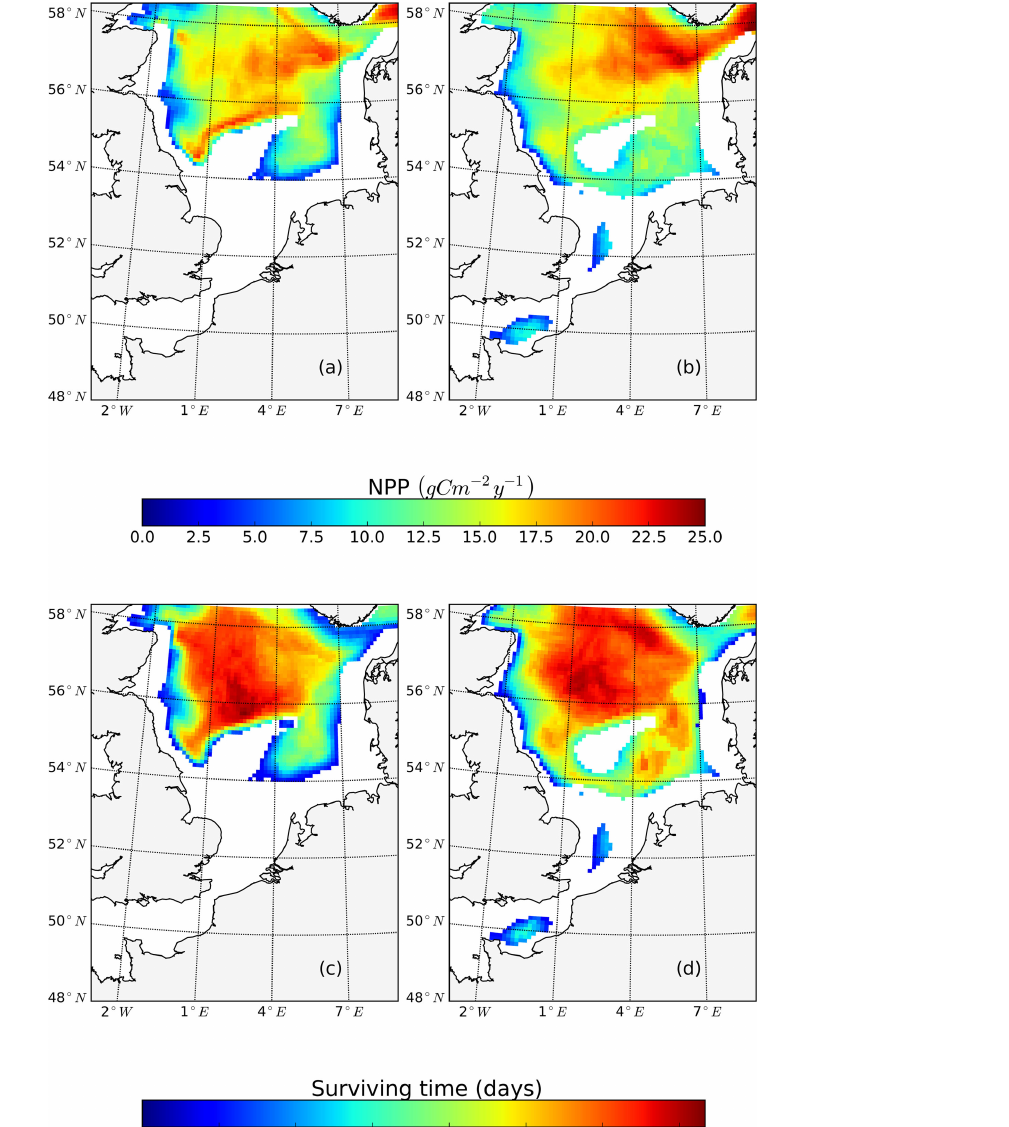
Figure A3. Annual mean NPP contributed by SBM in the tidal (a) and non-tidal scenarios (b) . Survival time of the SBM for the tidal (c) and non-tidal (d) scenarios.